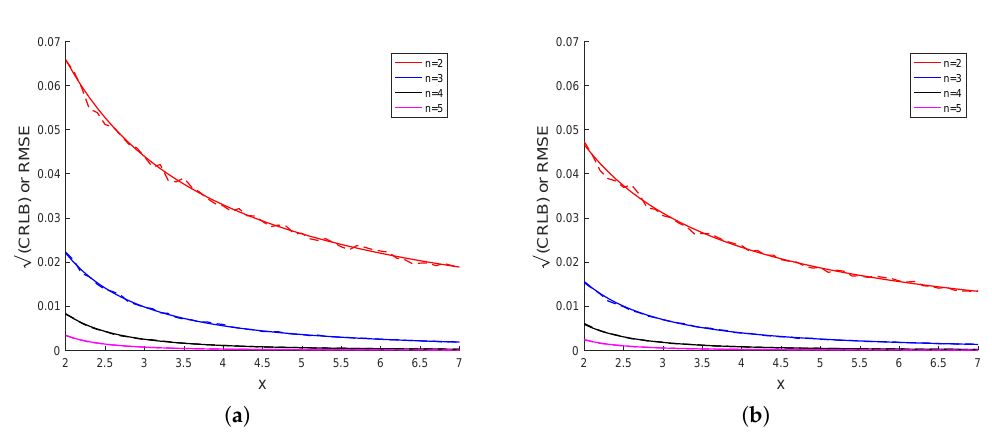
√ Figure 5. ( a ) CRLB or RMSE vs. x using 10 scalar measurements and ( b ) using 20 scalar measurements.